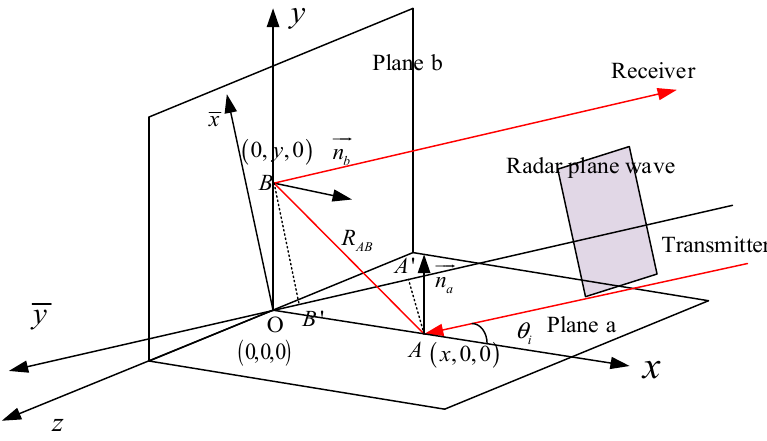
Figure 1. Geometric optical path of the orthogonal dihedral corner.